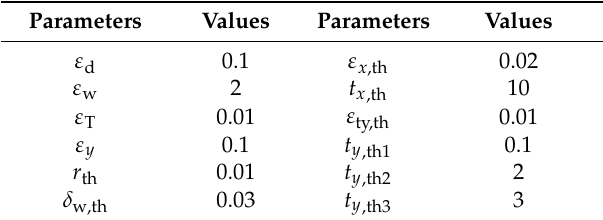
Table 3. Recommended parameters of the estimation algorithm.